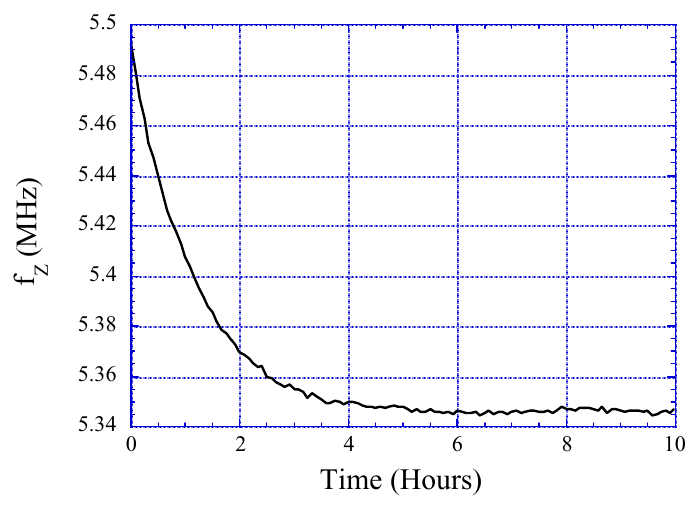
Figure 13. The change in f of an LC sensor immersed in water, as a function of time, due to z water absorption in the 150 µm thick polyurethane layer.